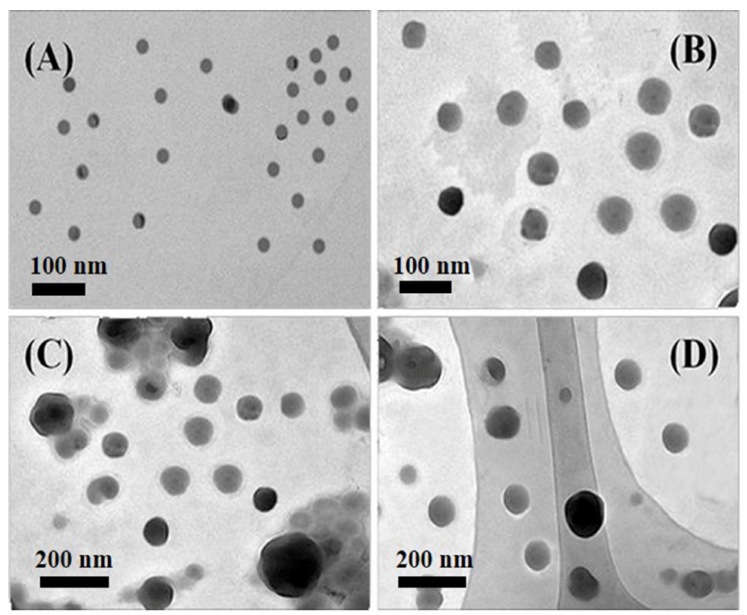
Figure 1. TEM images of di ff erent micelles obtained from P(MQ-co-St)-b-PNIPAM assembly: M4-1 ( A ),